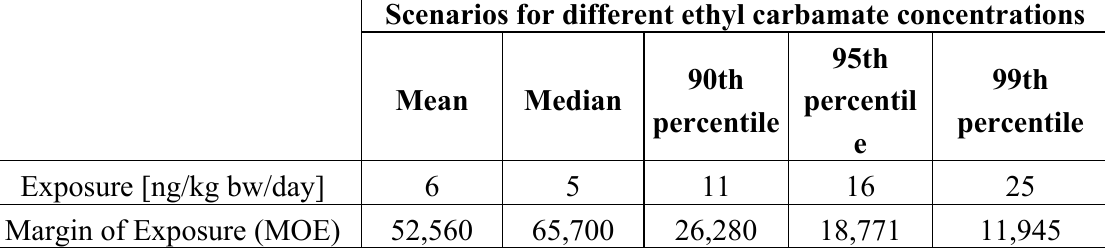
Table 3. Whole population risk assessment of ethyl carbamate in Mexico. Assumptions: annual per capita consumption of 1 litre of pure alcohol in the form of agave spirits; alcoholic strength of 40% vol; 60 kg person.